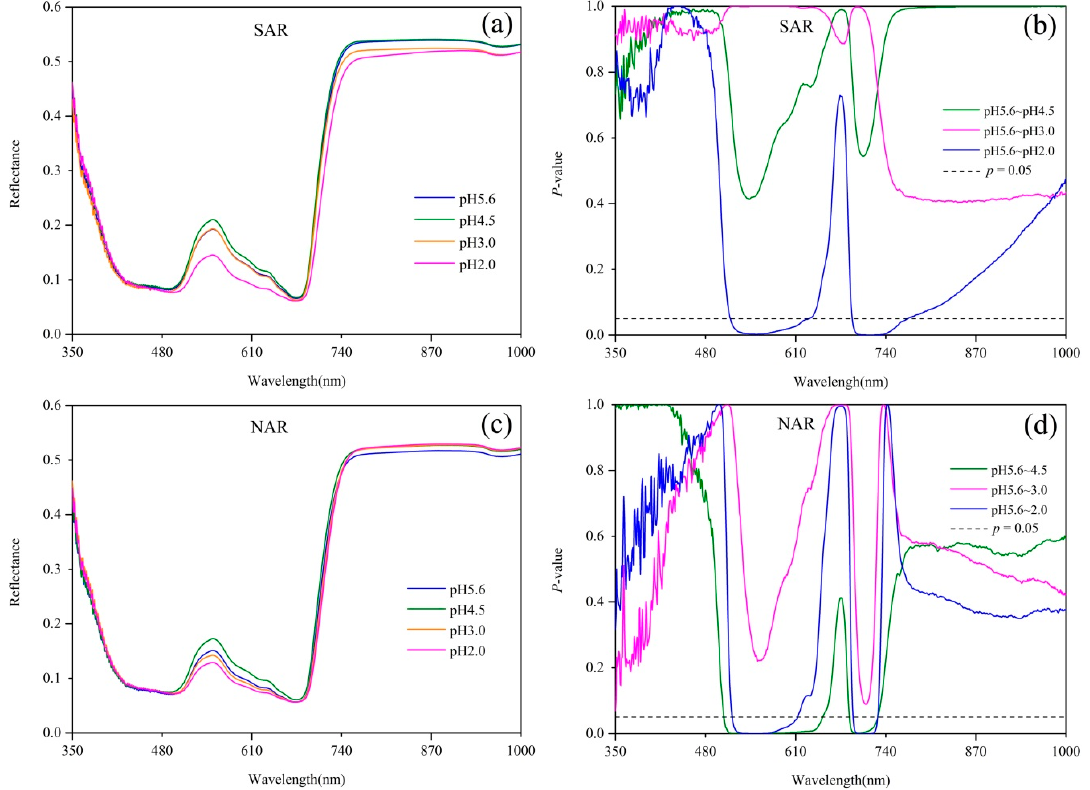
Figure 1. ( a ) Spectral reflectance and ( b ) its difference of Q. glauca under 4 pH levels of SAR, and ( c ) Spectral reflectance and ( d ) its difference of Q. glauca under 4 pH levels of NAR. p = 0.05 line indicates statistically significant difference between treatments according to Dunnett’s test results.